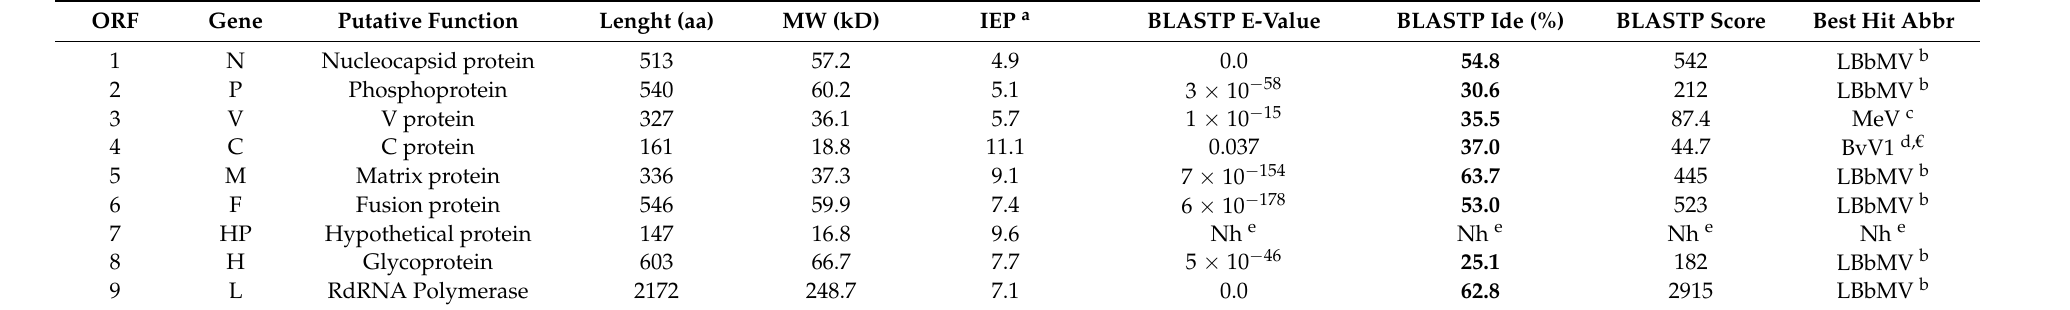
Table 2. Summary of RoMV genome-encoded proteins and best blasp